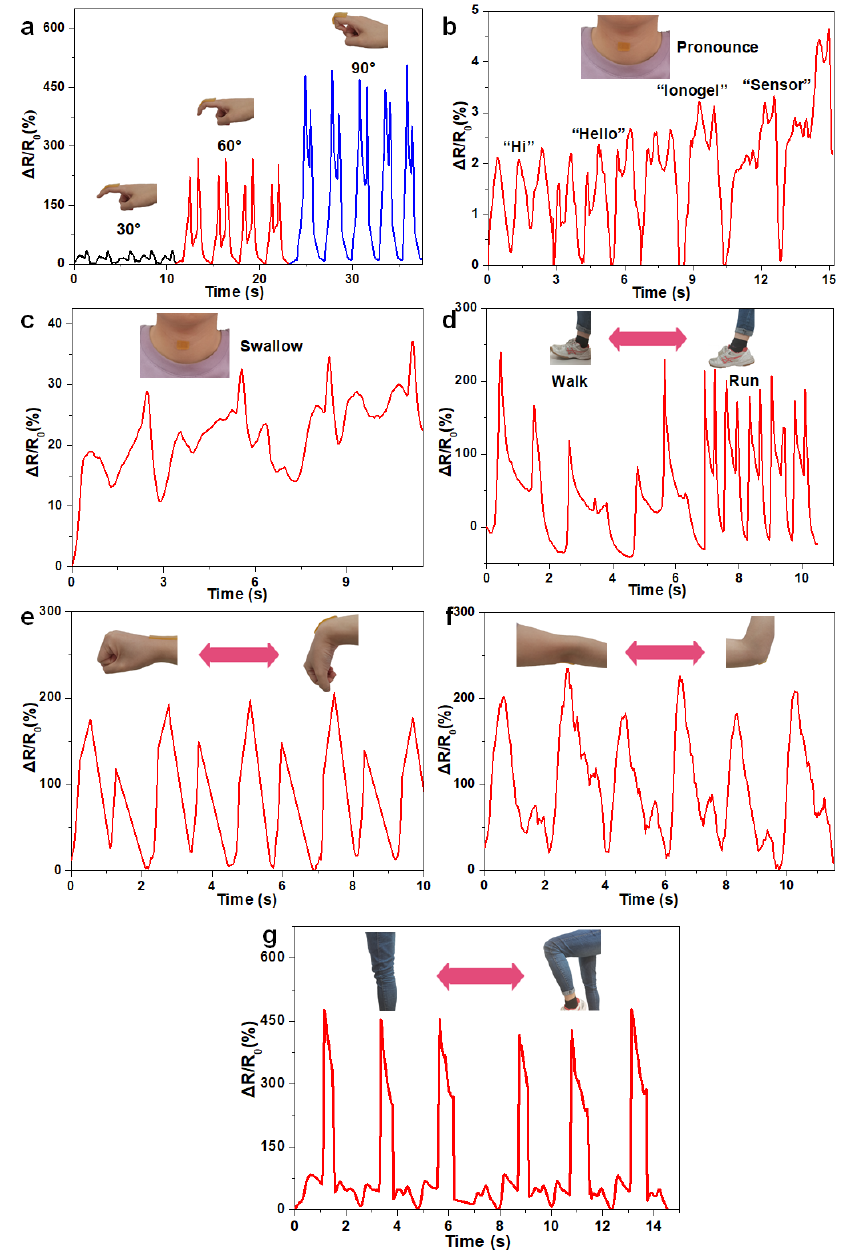
Figure 9. The CS/PAA DN ionogel as a flexible sensor to detect practical human physiological activity: continuously bending fingers at different angles ( a ), vocalization when saying some different words ( b ), throat swallow jitter ( c ), pressure on foot when walking and running on the ground ( d ), persistent bending joints from different parts of the body (wrist ( e ), elbow ( f ) and knee joint ( g